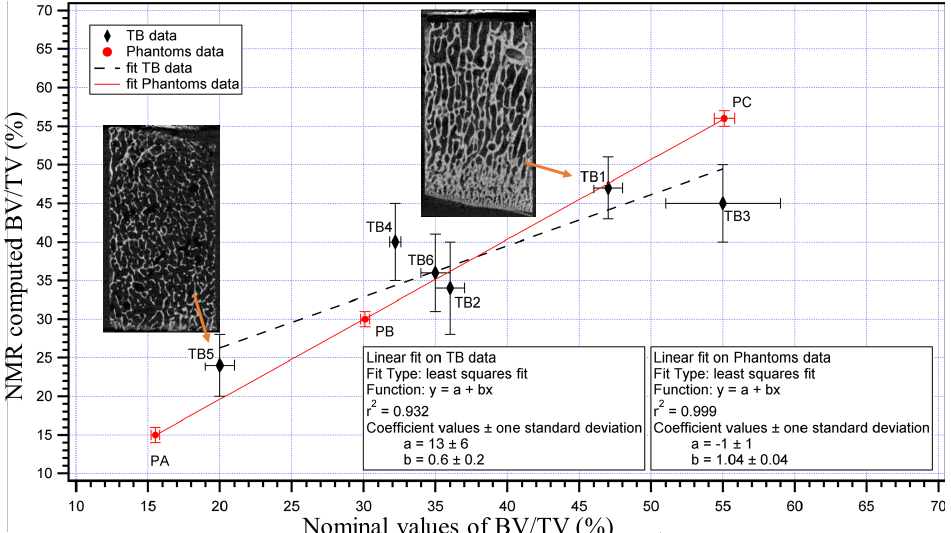
Figure 5. BV/TV values of TB animal samples and phantoms samples measured by single-sided scanner NMR-MOUSE PM10 (Magritek, Nz) vs. the nominal values. For the TB samples, the nominal values are the BV/TV values determined by the micro-CT analysis, whereas, for the phantoms, they have been obtained by the geometry of the samples. Examples of micro-CT images are reported for two TB samples. The figure was modified from reference [47]. Copyright (2017) Wiley, Copyright (Year) Wiley. Used with permission from reference